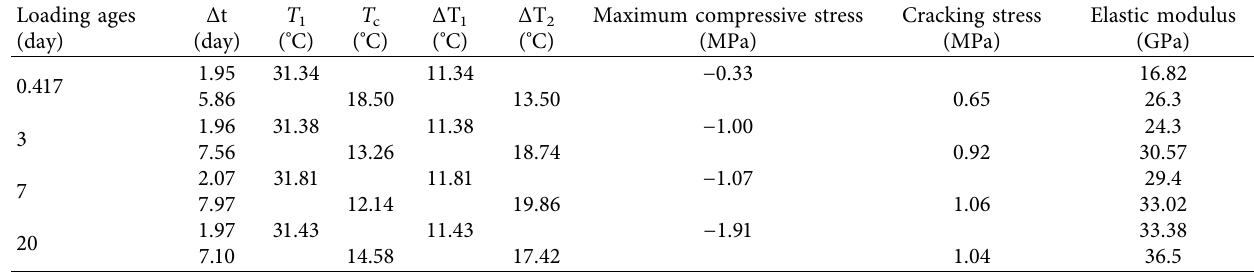
Table 6: Test data for thermal cracks analysis in LHP cement concrete.